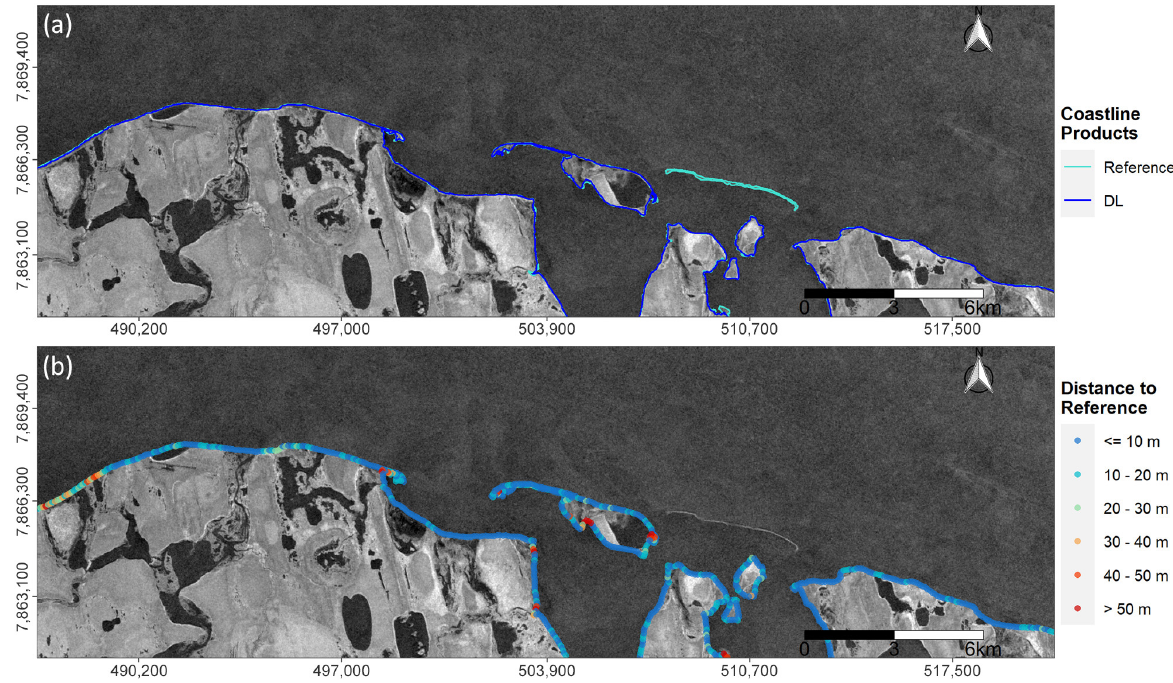
Figure 9. Comparison between the location of the reference coastline (turquoise line) and the DL- based predicted coastline (dark blue line) ( a ) as well as the distance of the predicted line to the reference data ( b ) for Drew Point–Cape Halkett, USA (aoi 02). An S1 annual median backscatter image for the year 2020 (months June–September) in VV polarization is used as a background image. Table 4. Comparing the distance of different coastline products to the reference coastline. Four different coastline products are listed. The Deep Learning (DL)-based coastline product that was computed within the framework of this study as well as the existing coastline products, Circumpolar Arctic Vegetation Map (CAVM), OpenStreetMap (OSM), and the Global Self-consistent, Hierarchical, High-resolution Geography Database (GSHHG). Various statistics are listed, including the arithmetic mean, minimum (Min), maximum (Max), standard deviation (SD), median, and the 2nd (P02) and 98th (P98)